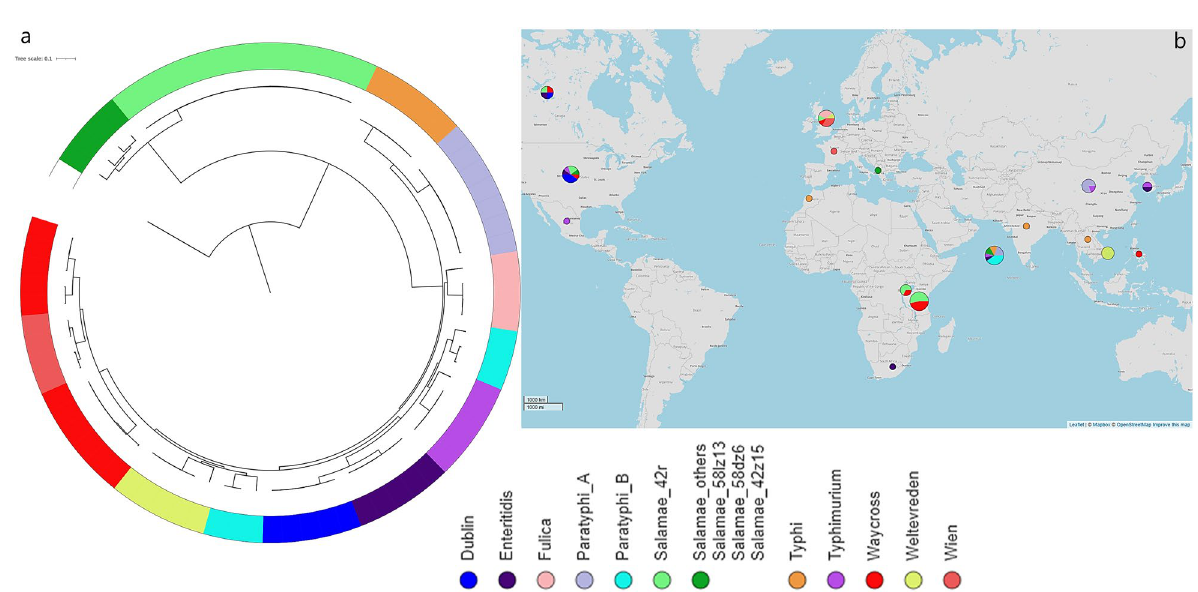
Figure 5. Phylogeny of S. Waycross and S. Salamae from Lake Victoria in a global S. enterica context; ( a ) SNP- tree showing clustering of the strains colored by serovars; ( b ) geographical distributions of the serovars included in the analysis. Bigger circles illustrate geographical areas with higher number of strains included in the analysis. The Map in panel ( b ) is generated from Microreact (https:// micro react. org/) using geographical coordinates of the place of isolation of analyzed